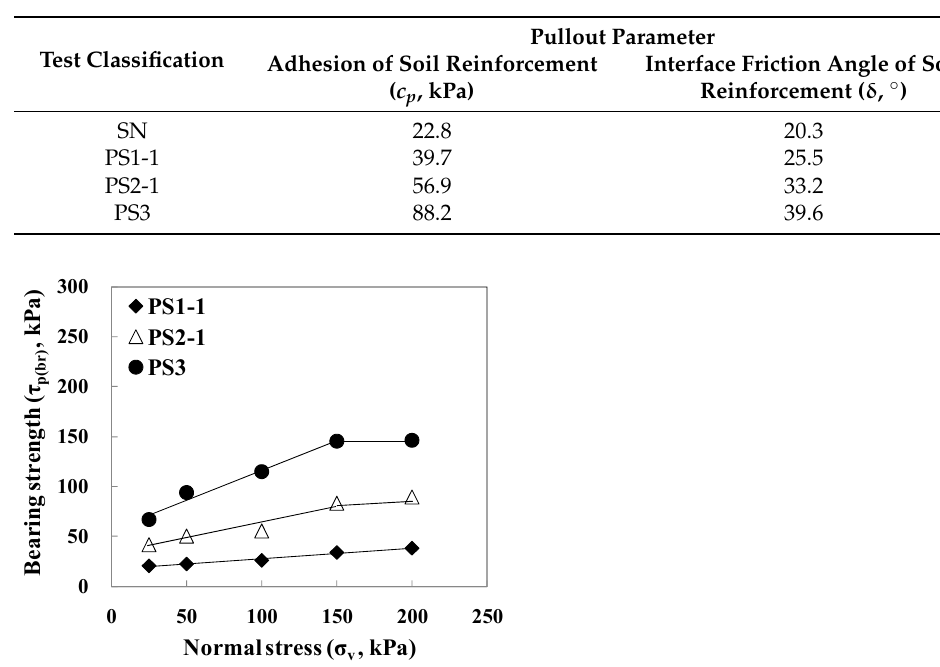
Figure 5. Relationship between normal stress and pullout strength. Table 3. Soil characteristics.